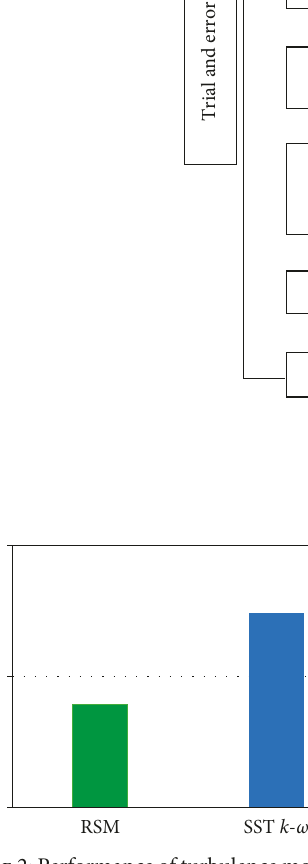
Figure 2: Performance of turbulence models in predicting pressure loss (data source: Kaushal et al., 2005